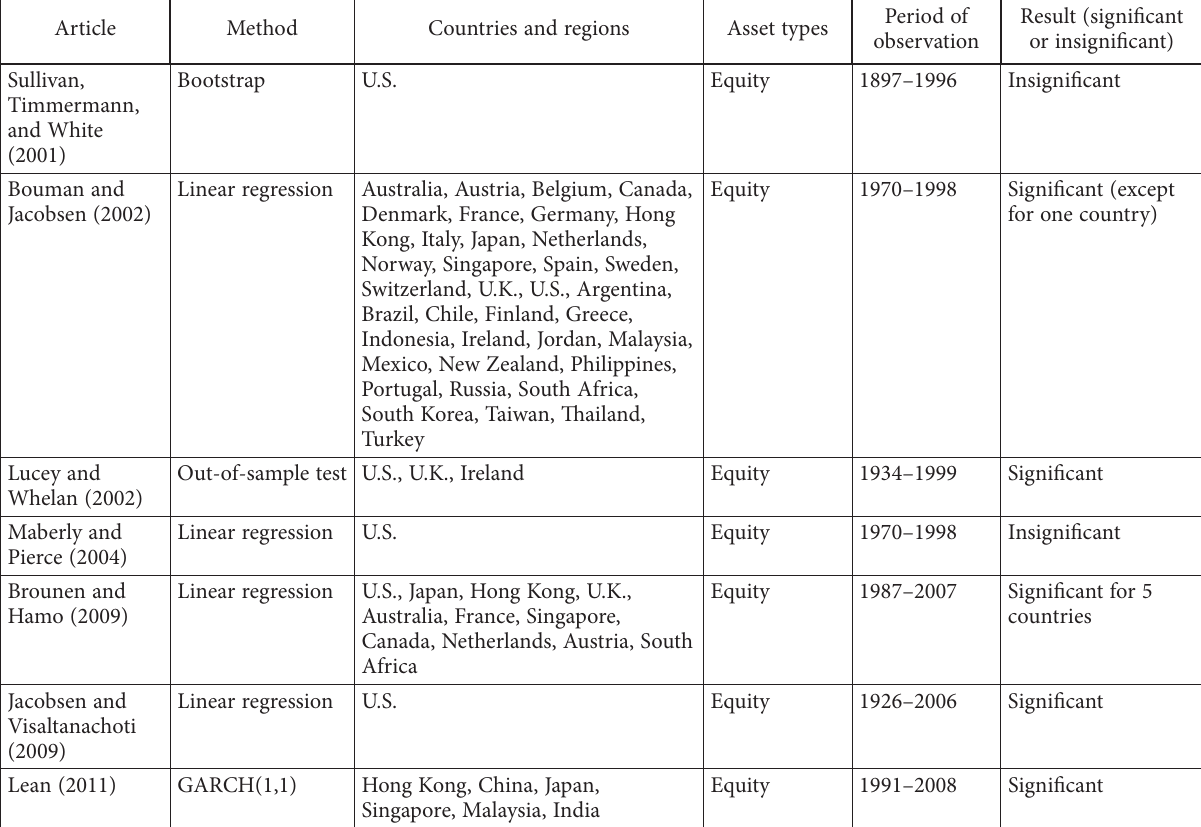
Table 1. Results of previous works on Halloween Effect (source: Hui & Chan, 2015,